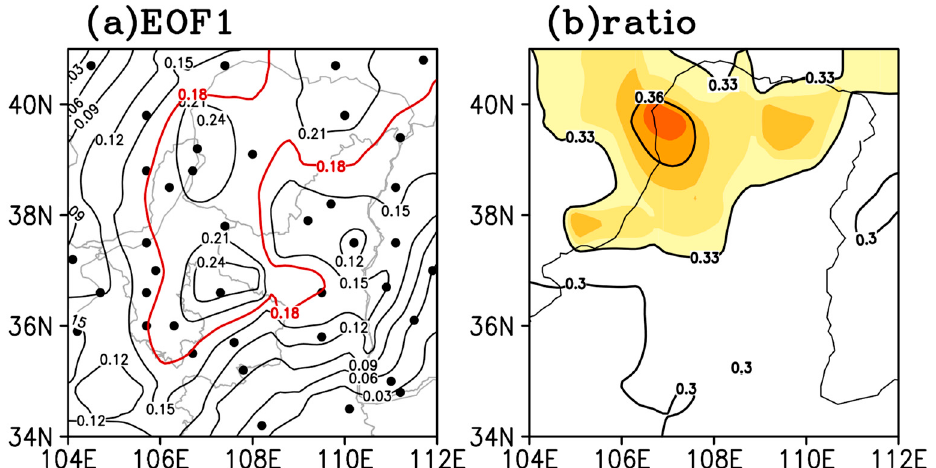
Figure 3. ( a ) The first EOF mode of the station-based extreme precipitation days (explaining 18.8% of the total variance); the black dots indicate the spatial distribution of the selected stations over the YRLV. The region enclosed by a red solid line is the key region used to define the REP over the YRLV. ( b ) The ratio of summer extreme precipitation to total summer precipitation over the YRLV; the shaded region denotes that the ratio exceeds 0.33 (33%).